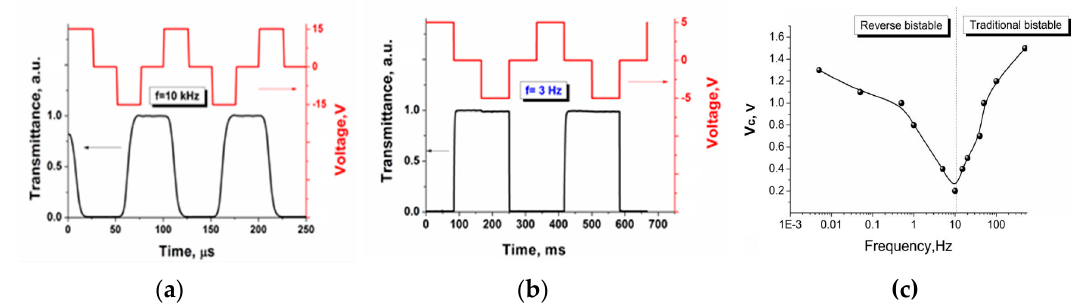
Figure 10. Electro-optical response of ( a ) traditional bistable and ( b ) reverse bistable FLC. The polarizer is placed along angle β with respect to helical axis, where β = θ and θ is the tilt angle of ferroelectric liquid crystal. ( c ) is the frequency characteristics of the hysteresis loop width [35].